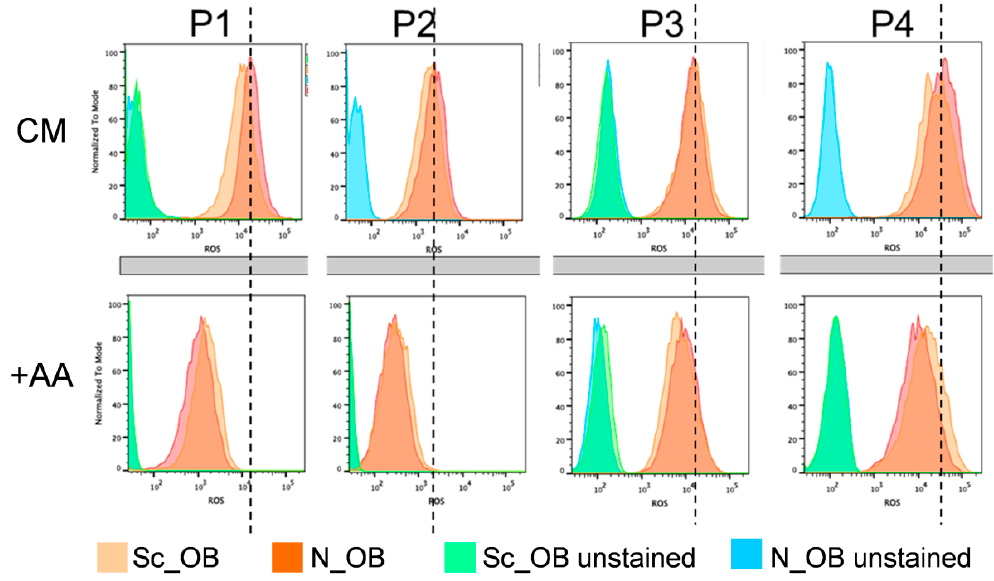
Figure 3. Effect of AA on reactive oxygen species (ROS) expression. The amount of ROS was determined by FACS for Sc_OB and N_OB, expanded in the absence (CM, upper panel) or presence of 0.1 mM AA (lower panel). The dashed lines visually depict the peak of ROS for Sc_OB (representative also for N_OB) in standard culture medium (CM).